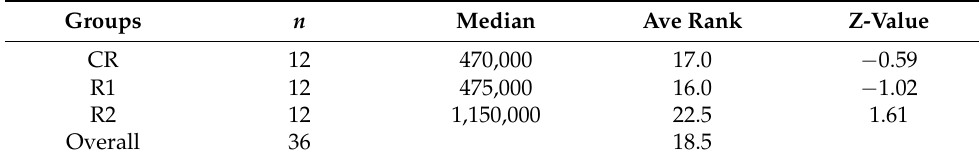
Table 8. CFU/specimen values for the